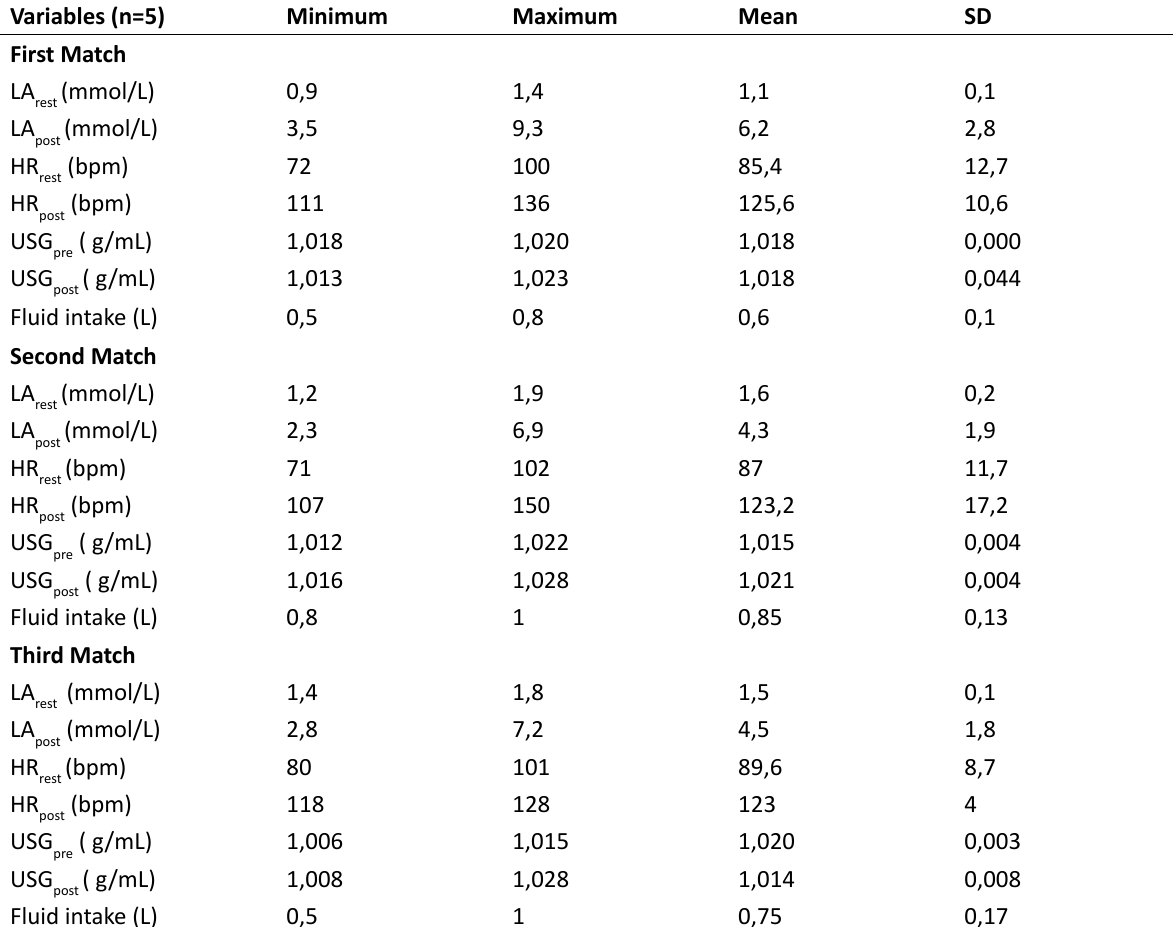
Table 1. Lactate, hearth rate, USG values and fluid intake of female handball